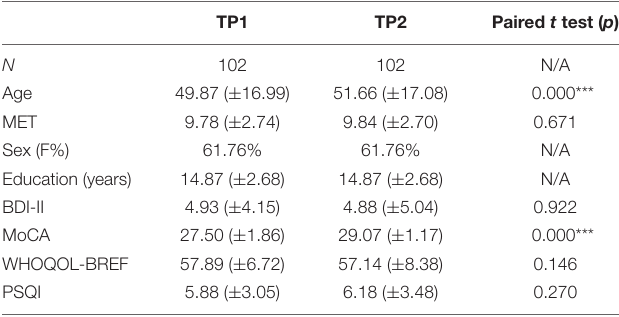
TABLE 1 | Demographic information and neuropsychological test results for the participants assessed at two time points. TP1 TP2 Paired t test ( p )